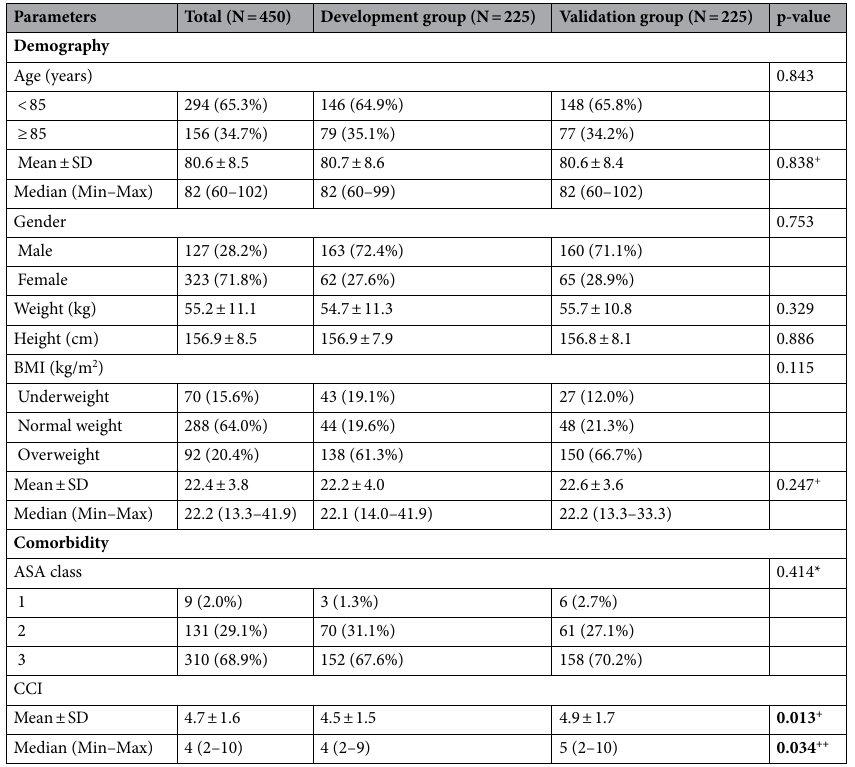
Table 1. Clinical characteristics and comorbidity of patients with intertrochanteric fracture. BMI body mass index, CCI Charlson comorbidity index, cm centimeter. Chi-square; *Fisher’s exact test; + Independent t test; ++ Mann–Whitney U test. Significant values are in